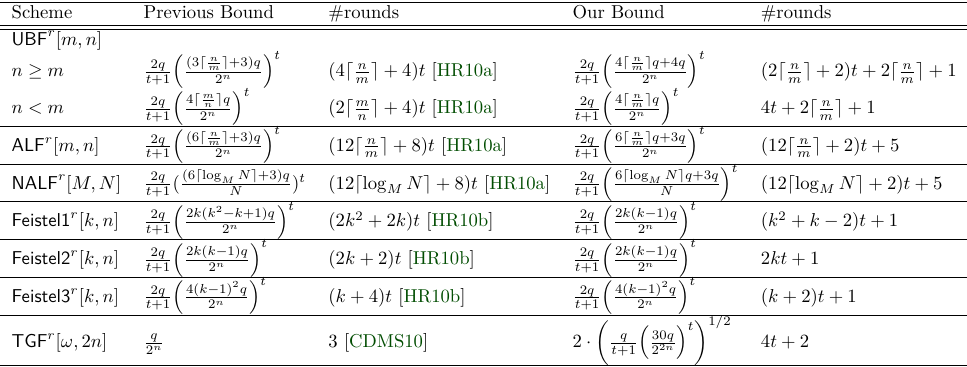
Table 1: Summary of improved CCA bounds in this paper. The rows correspond to the generalized Feistel networks illustrated in Fig. 1 and Fig. 2. Parameters k, m, n, ω, M, N describe the scheme and t determines the number of rounds r